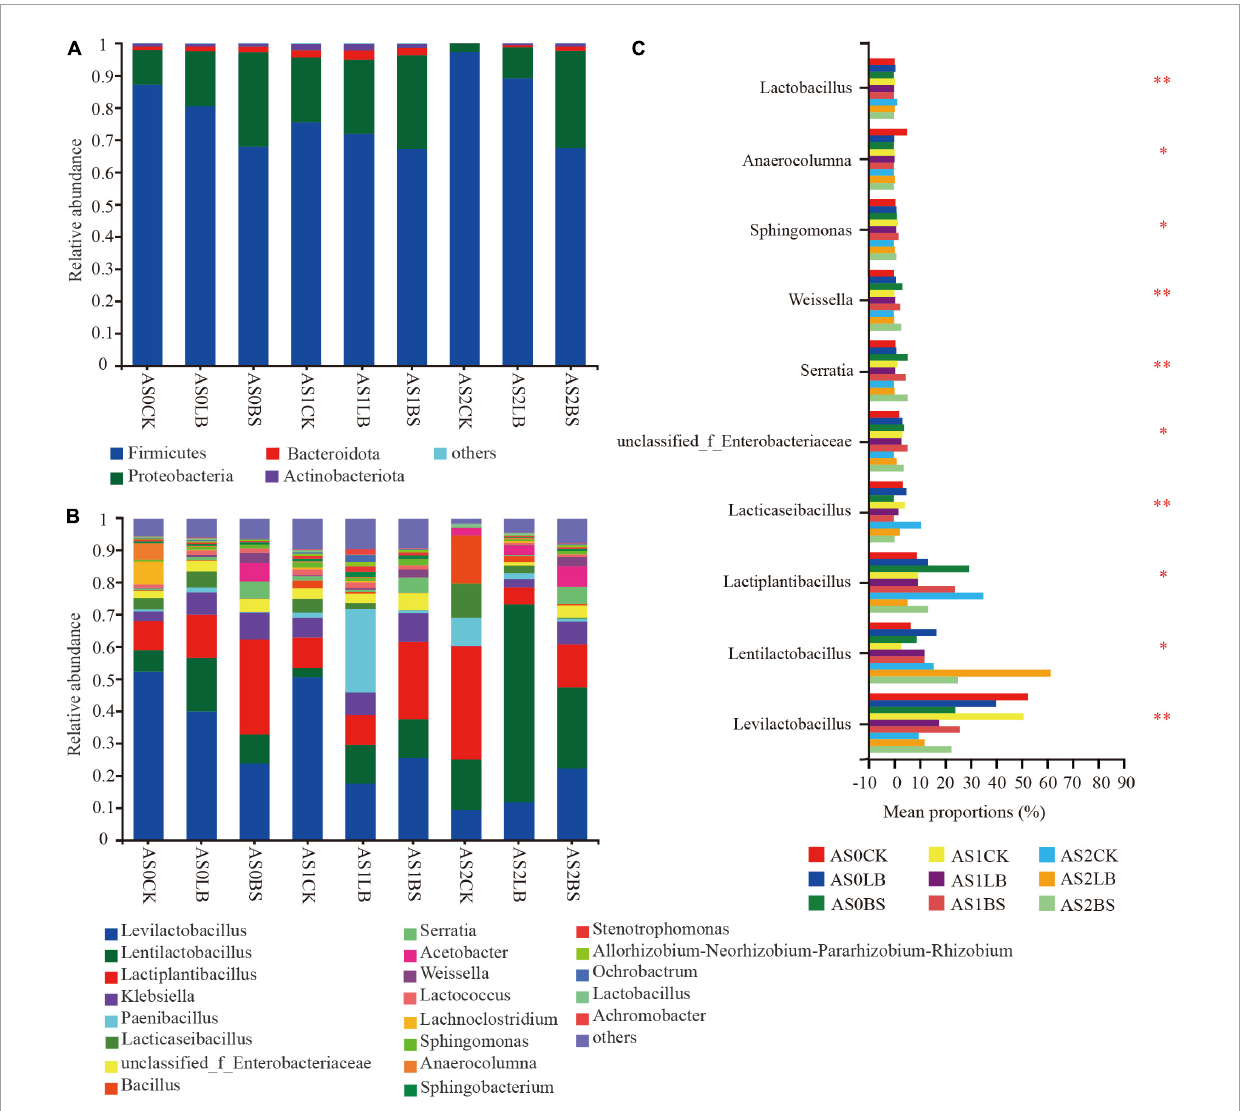
FIGURE6 Dynamic changes in relative abundance of bacteria at the phylum level (A) and genus level (B) during aerobic exposure and the differences in genus level (C) . ∗ Significance at P < 0.05; ∗∗ significance at P < 0.01. AS0CK, not inoculated silage at 0 h of aerobic exposure; AS0LB, Lentilactobacillus buchneri inoculated silage at 0 h of aerobic exposure; AS0BS, inoculated Bacillus subtilis silage at 0 h of aerobic exposure; AS1CK, not inoculated silage at 18 h of aerobic exposure; AS1LB, Lentilactobacillus buchneri inoculated silage at 18 h of aerobic exposure; AS1BS, inoculated Bacillus subtilis silage at 18 h of aerobic exposure; AS2CK, not inoculated silage at 60 h of aerobic exposure; AS2LB, Lentilactobacillus buchneri inoculated silage at 60 h of aerobic exposure; AS2BS, inoculated Bacillus subtilis silage at 60 h of aerobic